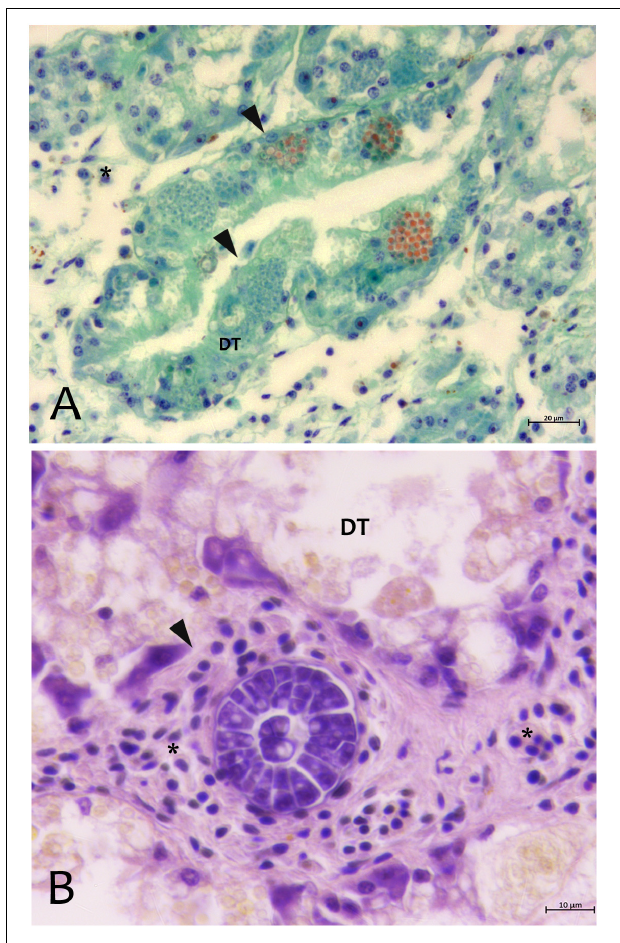
FIGURE 3 | Parasites observed in Campania (A) and Sardinia samples (B) of P. nobilis . (A) Digestive gland of Pinna nobilis infected with by H. pinnae in the digestive tubules (DT) showing sporocysts with deeply stained plasmodia in green, and mature spore in bright orange stained with V.O.F. stain (arrows). (B) Perkinsus sp. with encapsulated multicellular trophozoites (rosettes) in the interstitial space of digestive gland. ∗ haemocytes; DT, digestive